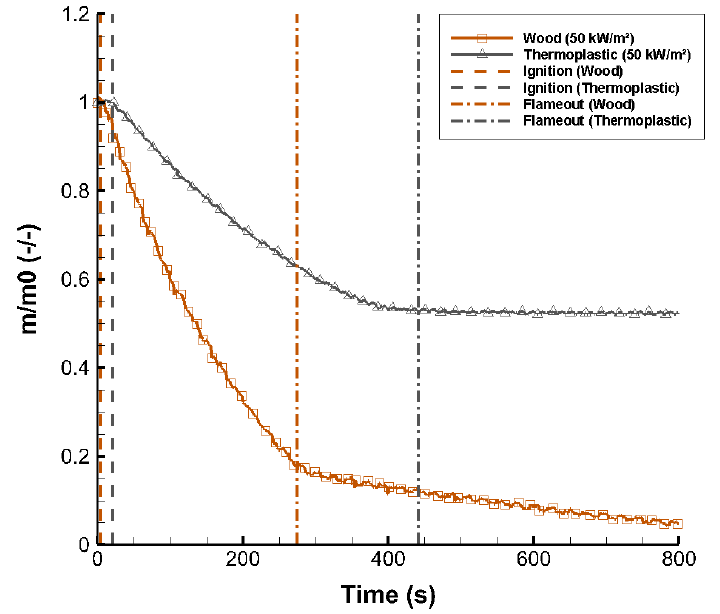
Figure 2. Non-dimensional mass loss as a function of time for an exposed heat flux of 50 kW/m 2 for wood ( □ ) and thermoplastic ( △ ) samples.